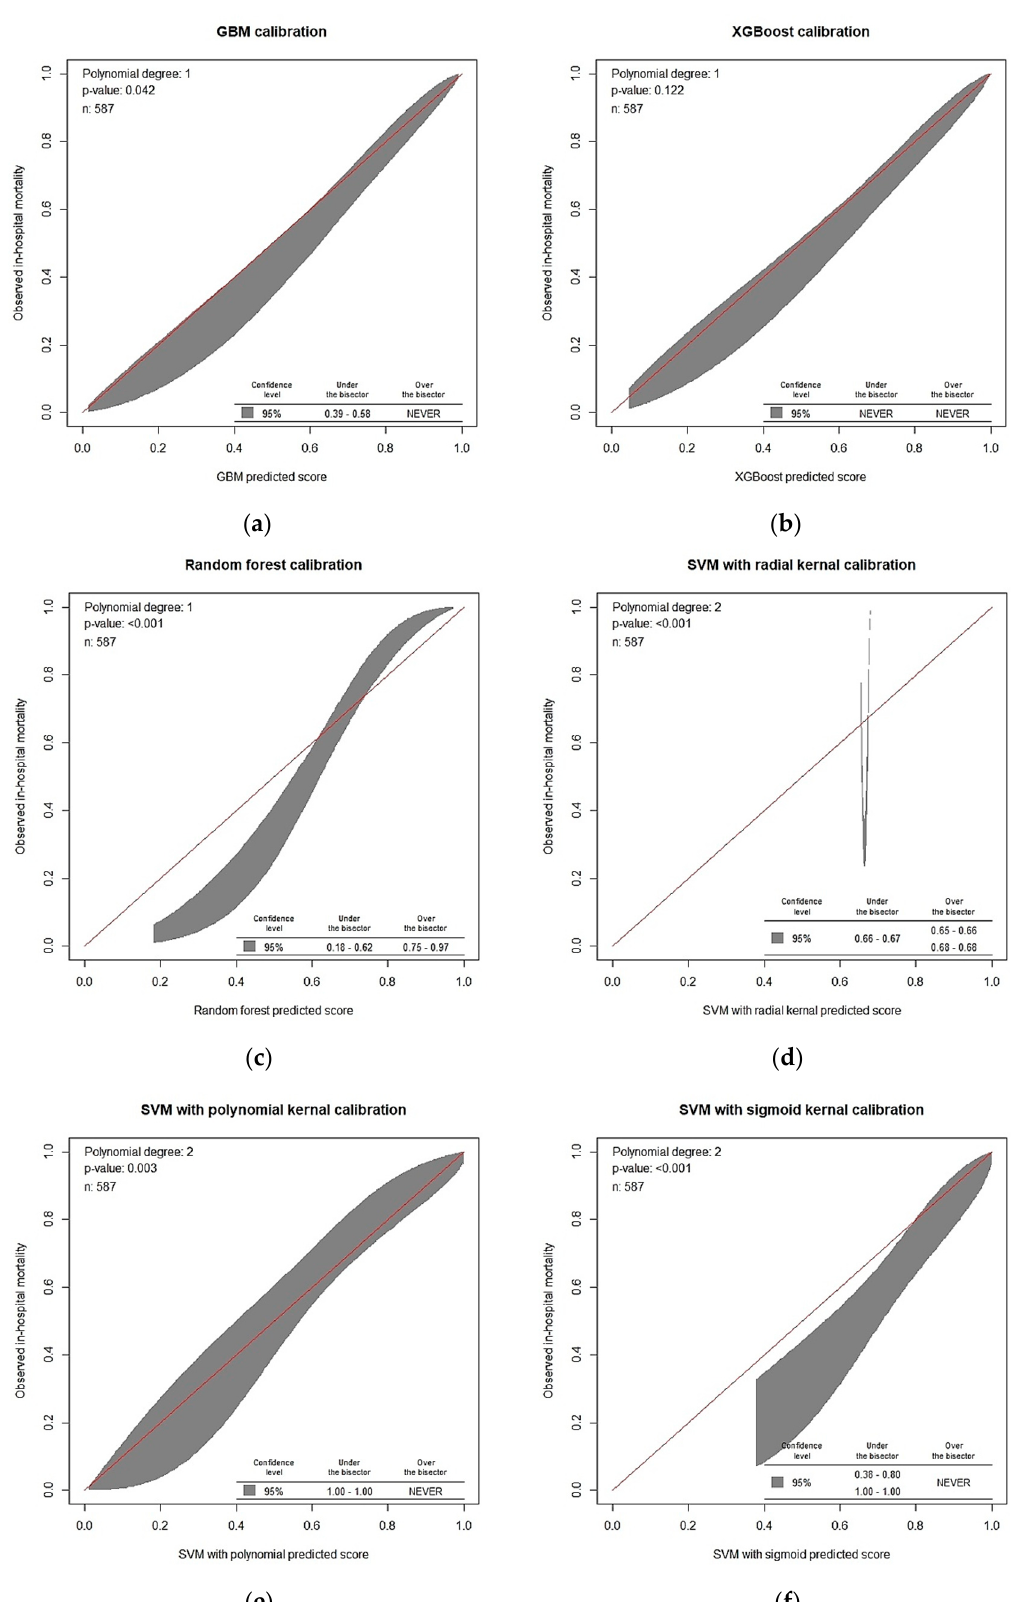
Figure 4. The raincloud plot of in-hospital mortality predicted score in machine learning methods. ( a ) GBM, XGB and random forest, ( b ) SVM with radial kernel, SVM with polynomial kernel, and SVM with sigmoid kernel.